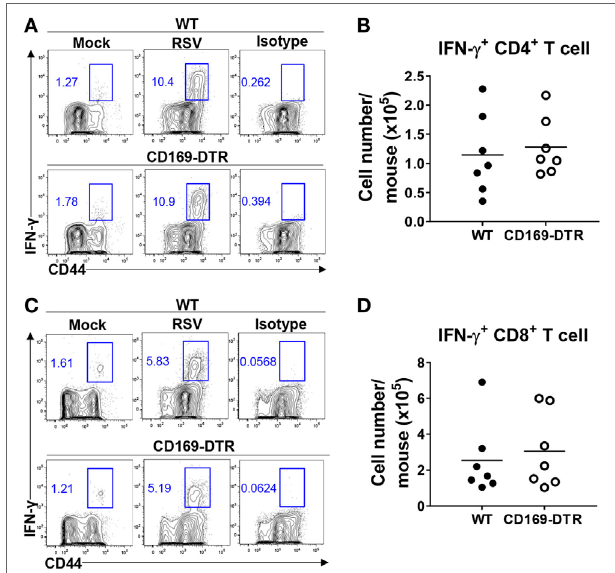
FigUre 5 | CD169 + cell depletion is dispensable for the adaptive immune response against respiratory syncytial virus (RSV). Seven days after RSV infection, interferon (IFN)- γ production by activated CD4 + or CD8 + T cells from lungs was measured by intracellular cytokine staining after stimulation with PMA and ionomycin (for CD4 + T cells) (a) or H-2Db-restricted M 187–195 peptides (for CD8 + T cells) (c) . The frequencies and absolute cell numbers of CD44 + IFN- γ + CD4 + (a,B) and CD8 + (c,D) T cells were assessed. Cell number results from RSV-infected mice are shown in the graphs. Each dot represents an individual mouse ( n = 7 in each group). Data are representative of two independent